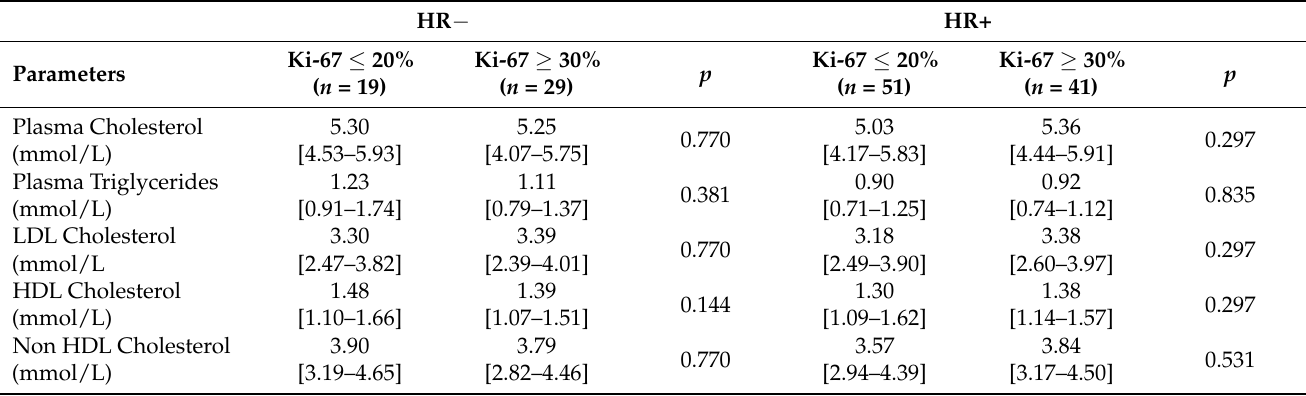
Table 2. Plasma and lipoprotein lipids in estrogen receptor-positive (HR+) and negative (HR − ) breast cancer patients, according to the proliferation index (Ki-67 ≤ 20% or Ki-67 ≥ 30%). Data are presented with median (25th–75th percentile).